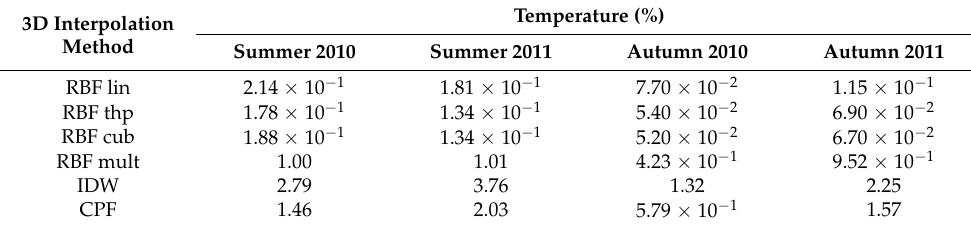
Table 3. The average MREs of different interpolation methods with in situ temperature.